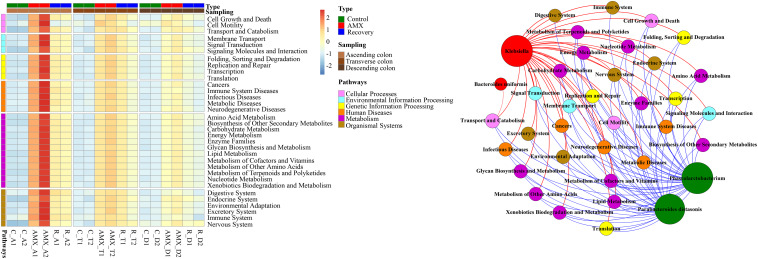
Heatmap of human disease-related pathways in the three parts of colon within three groups and the network analysis revealing the co-occurrence patterns between microbial taxa abundance and functional pathway gene number. Heatmap colors reflect relative abundance from low (blue) to high (red). The nodes in network were colored according to types of functional pathway genes and microbial genera that increased (red) or decreased (green) after AMX exposure, and the edges were colored according to positive (red) or negative (blue) correlation. A connection represents strong and significant (P value < 0.05, R > 0.6) correlation. The size of each node is proportional to the number of connections, that is, degree.